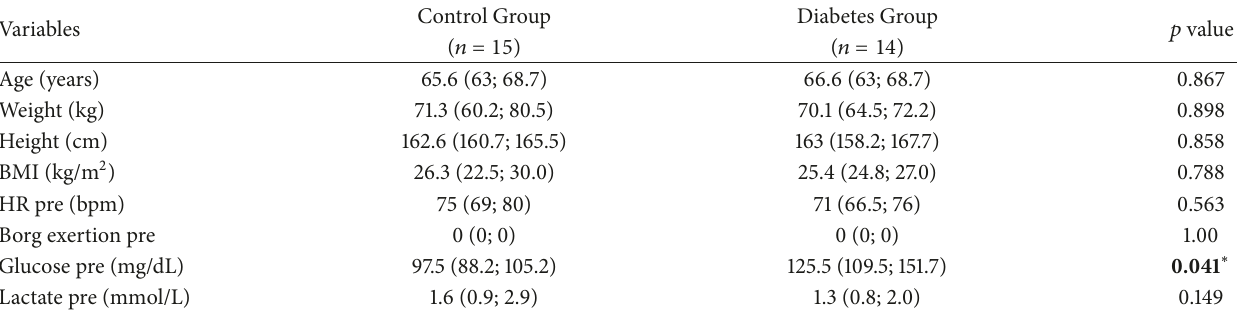
Table 1: Characteristics of control and diabetic groups at baseline.